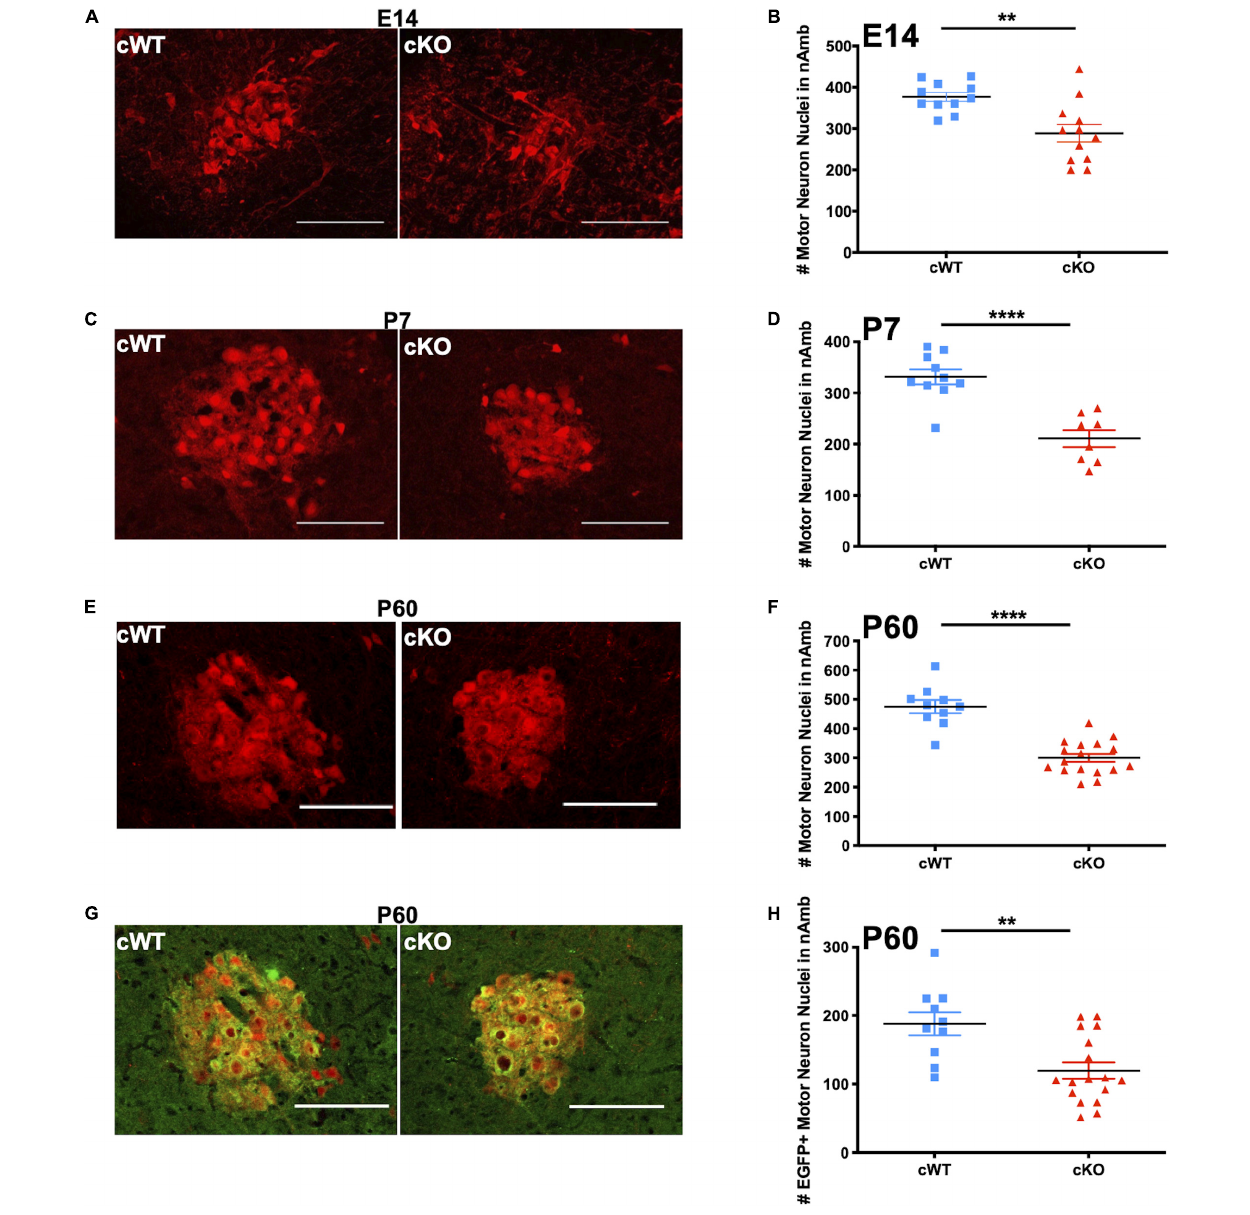
FIGURE 5 | Analyses of lifespan loss of vagal motor neurons in the nAmb following conditional deletion of MET. (A) Representative images of the nAmb from cWT and cKO mice on E14.5. (B) tdTom + cell counts from cWT and cKO mice on E14.5. n = 11 cWT, 12 cKO. “**” indicates p < 0.01 as analyzed by parametric unpaired t -test. (C) Representative images of the nAmb of cWT and cKO mice on P7. (D) tdTom + cell counts from cWT and cKO mice on P7. n = 10 cWT, 8 cKO. “***” indicates p < 0.0001 as analyzed by parametric unpaired t -test. (E) Representative images of the nAmb of cWT and cKO mice on P60. (F) tdTom + cell counts from cWT and cKO mice on P60. n = 10 cWT, 17 cKO. “****” indicates p < 0.0001 as analyzed by parametric unpaired t -test. (G) Representative images of EGFP + (green) motor neurons (tdTom +; red) in nAmb of cWT and cKO mice on P60. Images in E and G demonstrate EGFP and tdTom overlap from the same samples. (H) EGFP + cell counts from cWT and cKO mice on P60. n = 10 cWT, 17 cKO. “**” indicates p < 0.01 as analyzed by parametric unpaired t -test. Scalebars = 100 µ m. The brightness and contrast of each channel was adjusted separately for visualization purposes. Some images were cropped to center the nAmb in the image